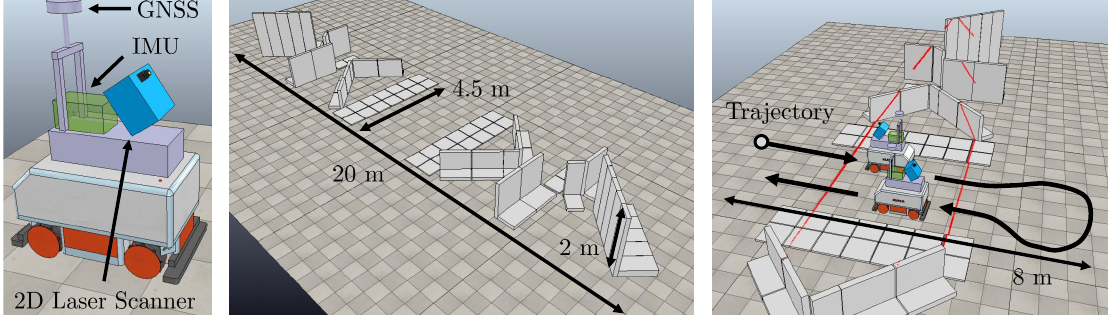
Figure 5. Using V-REP (Virtual Robot Experimentation Platform) for the simulation of the plane-based calibration approach: Mobile laser scanning system ( left ), plane setup ( middle ), kinematic data acquisition in the calibration field ( right